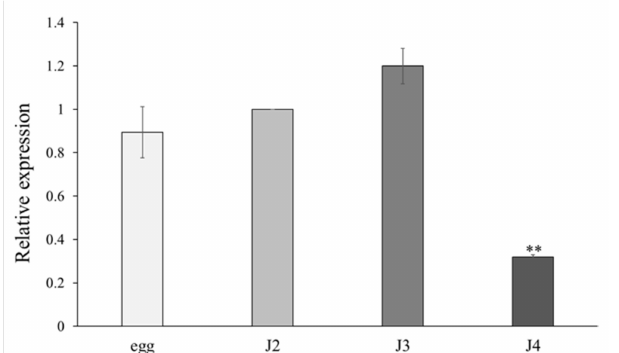
Figure 4. The relative expression levels of DdCa v β at different developmental stages of D. destructor . The expression level in J2s was used as the standard value. The data are presented as the mean ± s.d of three biological replicates and three technical replicates ( n = 9). Asterisks indicate a significant difference at the level of p < 0.01, as tested by Duncan’s new complex difference